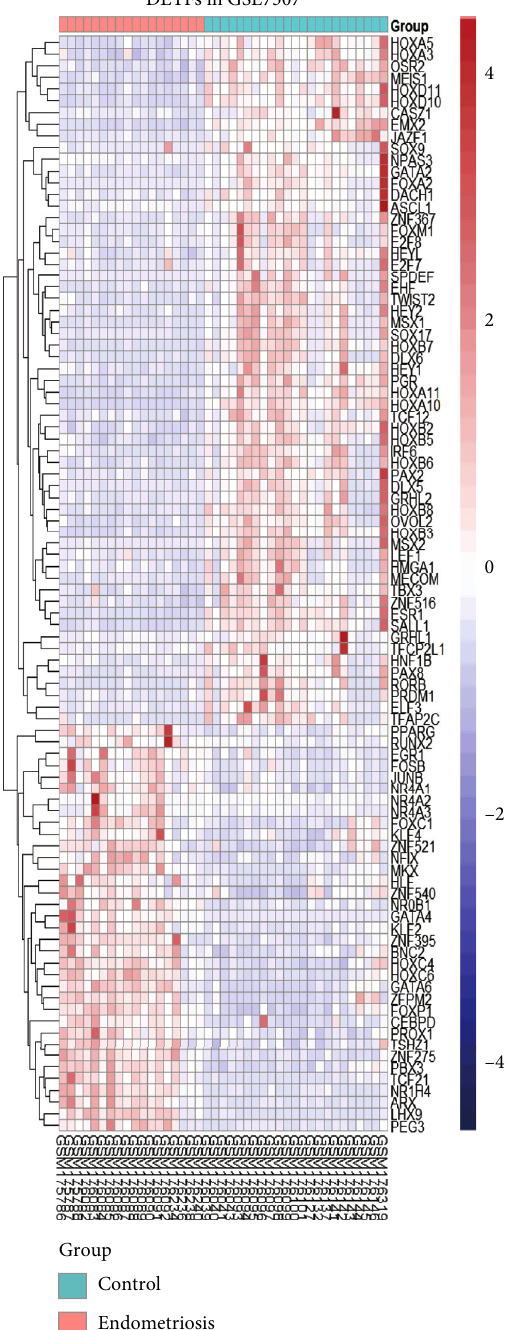
Figure 3: Heatmap of 94 DETFs in GSE7305. Each row represents a TF and each column represents a sample.